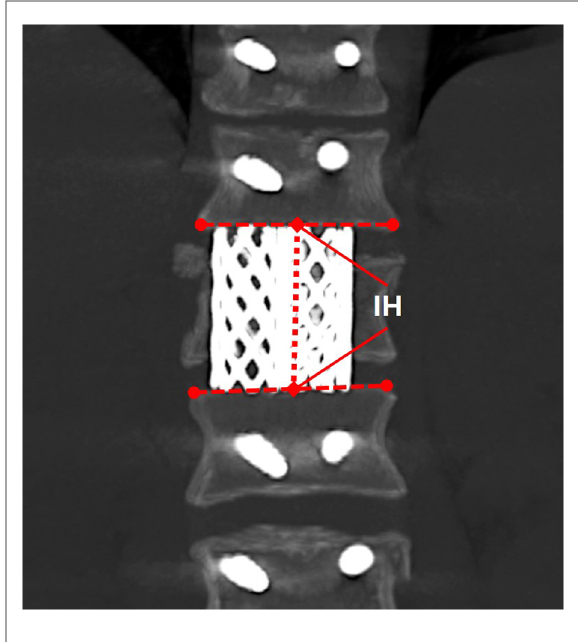
FIGURE 3 The intervertebral height (IH).